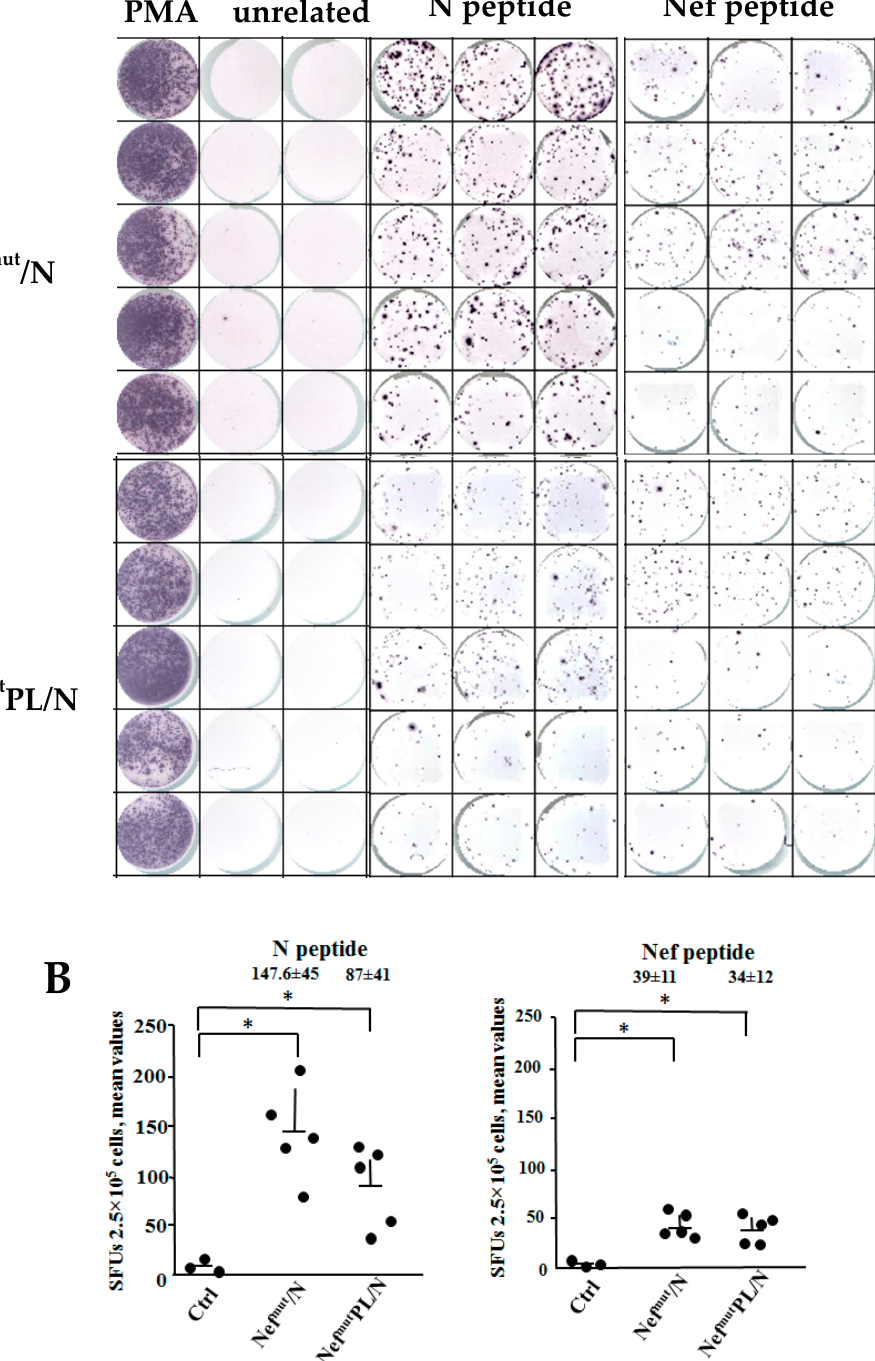
Figure 2. SARS-CoV-2-specific CD8 + T cell immunity induced in DNA injected mice. CD8 + T cell immune response in C57 Bl/6 mice inoculated i.m. with DNA vectors expressing either Nef mut /N, Nef mut PL/N or, as control, pVAX1. At the time of sacrifice, 2.5 × 10 5 splenocytes were incubated ON with or without 5 μ g/mL of either unrelated, SARS-CoV-2-N, or HIV-1 Nef-specific peptides in replicate IFN- γ EliSpot microwells. In panel ( A ), the raw data obtained with splenocytes from mice injected with either Nef mut /N or Nef mut PL/N are reported. PMA indicates cell cultures treated with PMA plus ionomycin. In panel ( B ), shown are the numbers of IFN- γ SFUs/well as mean values of triplicates after subtraction of mean values measured in wells seeded with splenocytes treated with unspecific peptides. Intragroup mean values + SD are also shown. The results are representative of two independent experiments. * p <